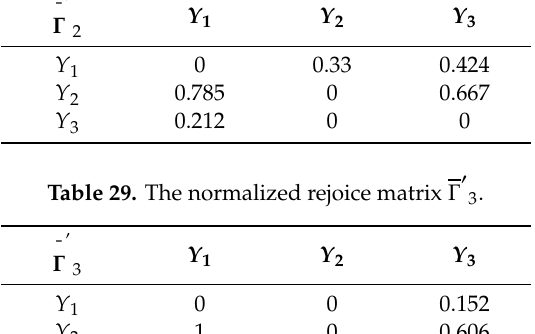
Table 28. The normalized rejoice matrix Γ